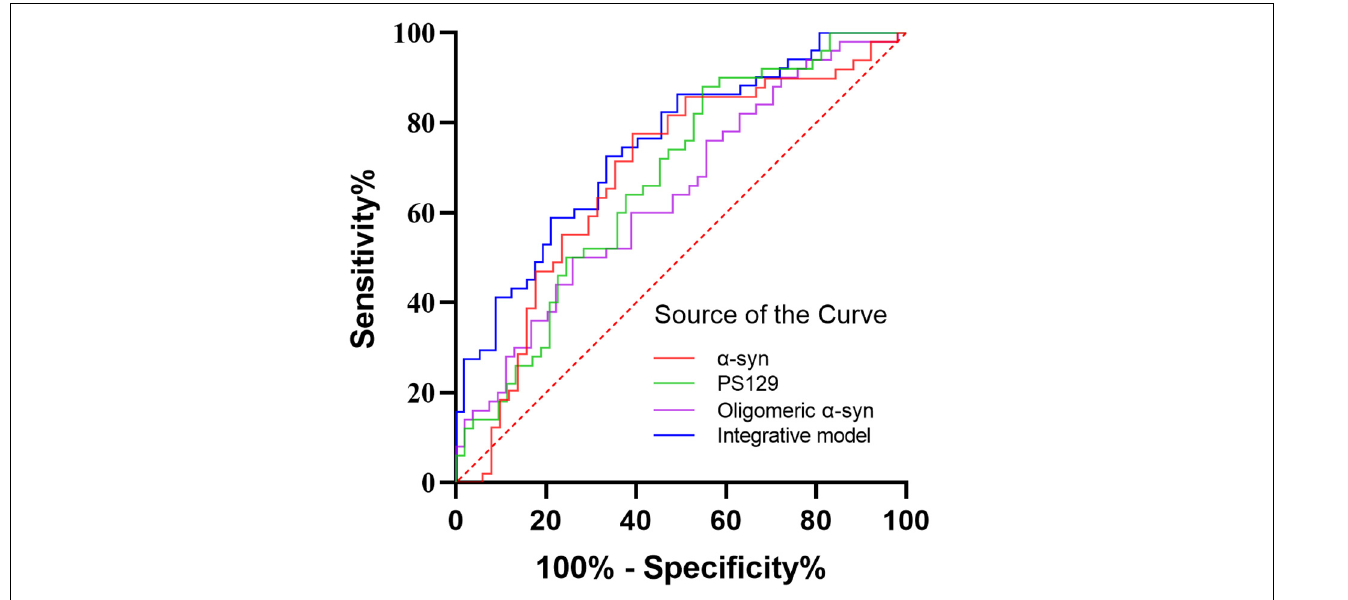
FIGURE 4 | The ROC curves for α -Syn, pS129, oligomeric α -Syn, and the integrative model. Red curve: α -Syn (AUC = 0.684); Green curve: pS129 α -Syn (AUC = 0.674); Purple curve: oligomeric α -Syn (AUC = 0.641); Blue curve: the integrative model including α -Syn, pS129 α -Syn, and oligomeric α -Syn (AUC =